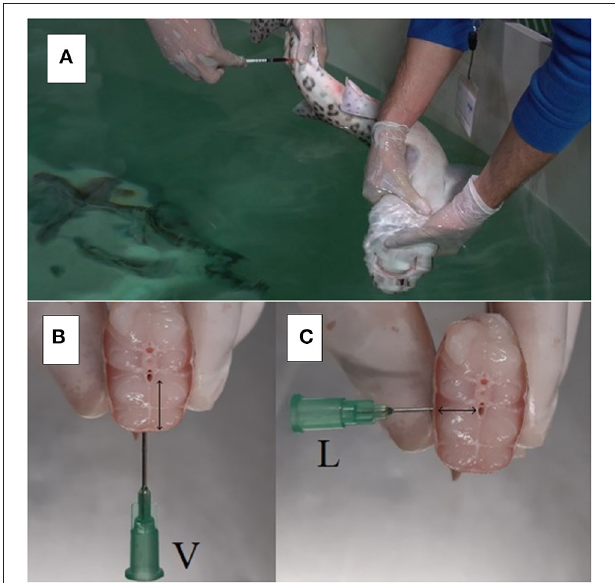
FIGURE 1 | Blood collection in an adult nursehound ( Scyliorhinus stellaris ) during PK study (A) . Note that the animal is manually restrained with its head and gills under water and blood is collected via lateral access to the caudal vasculature. Quarantine facilities, Oceanogràfic of Valencia, Spain. Caudal sagittal section in a nursehound shark during necropsy, dorsal is above and ventral is below; detail of the indicated for venipuncture site in elasmobranchs (B,C) . Please note that when performing the lateral access (L) to the caudal blood vasculature for venipuncture, the amount of traumatized muscle tissue ( ↔ ) is reduced compared to the ventral access (V; l